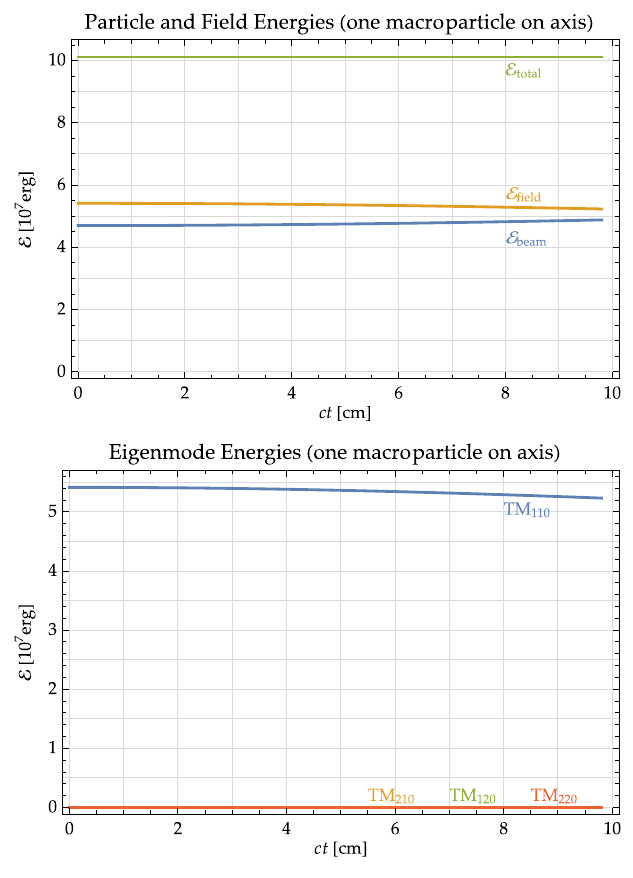
FIG. 1. Energy gain and eigenmode energy decomposition for the case of one macroparticle on